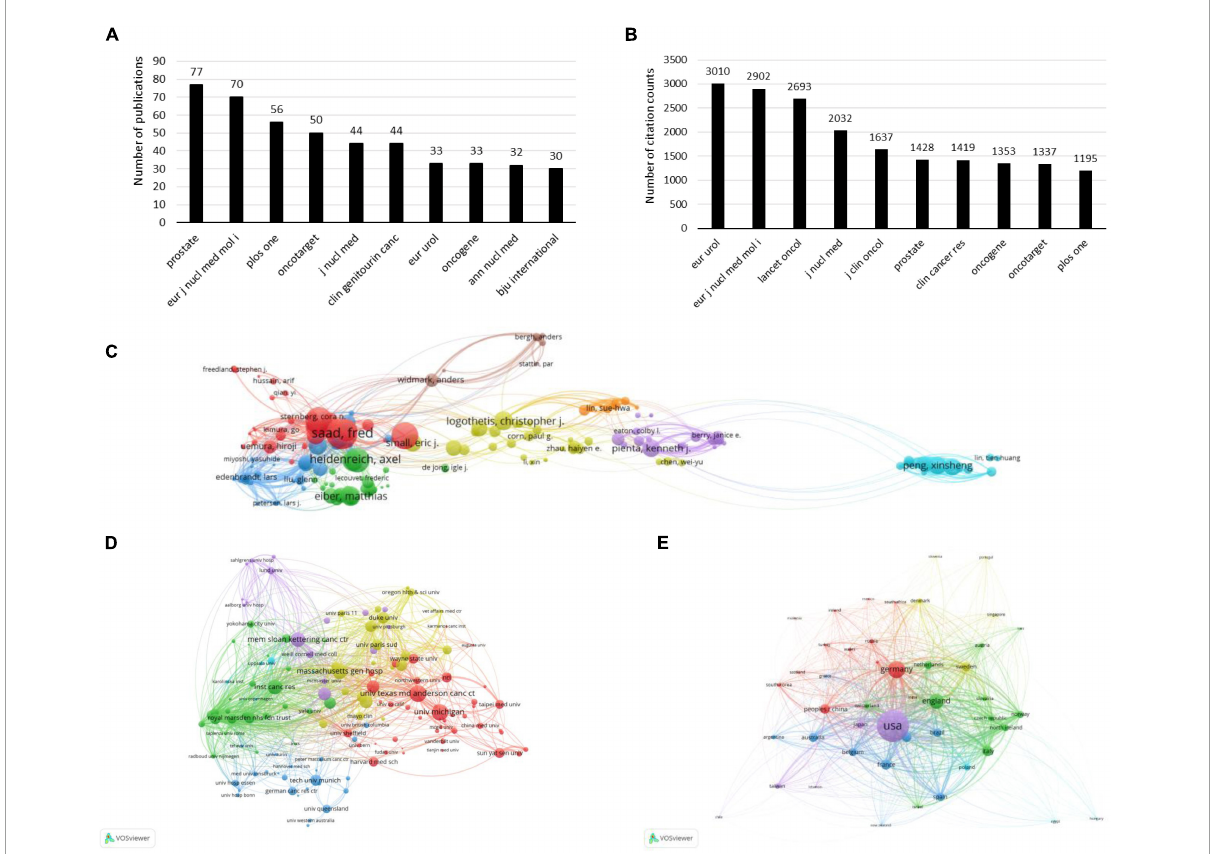
FIGURE3 The bibliometric analysis of the publications and citations on PCa bone metastasis. (A) The top 10 published journals in the field of PCa bone metastasis. (B) The top 10 cited journals in the field of PCa bone metastasis. (C) The bibliometric analysis of authors in the field of PCa bone metastasis. (D) The bibliometric analysis of institutions in the field of PCa bone metastasis. (E) The bibliometric analysis of countries/regions in the field of PCa bone